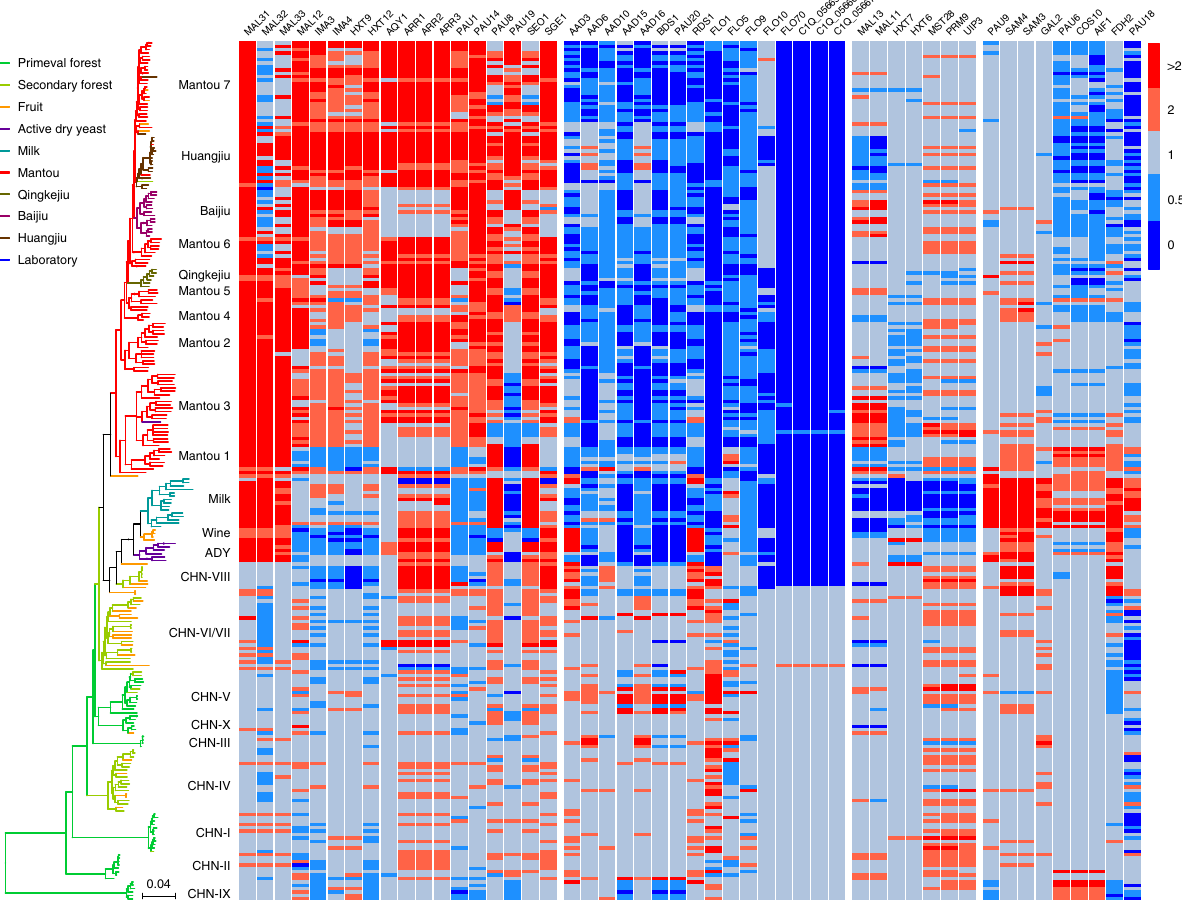
Fig. 3 Copy-number variation (CNV) of selected genes in wild and domesticated isolates of S. cerevisiae . Gene names are given at the top of the heat map. Isolates are represented by terminal branches in the phylogenetic tree constructed from the maximum likelihood analysis on genome wide SNPs and are colored according to their ecological origins. Heat map colors re fl ect different degrees of gene duplication (red shades) or deletion (blue shades) from the basal level (grey) according to the scale on the right with strain S288c as the reference. The exact relative values of CNV are given in Supplementary Data